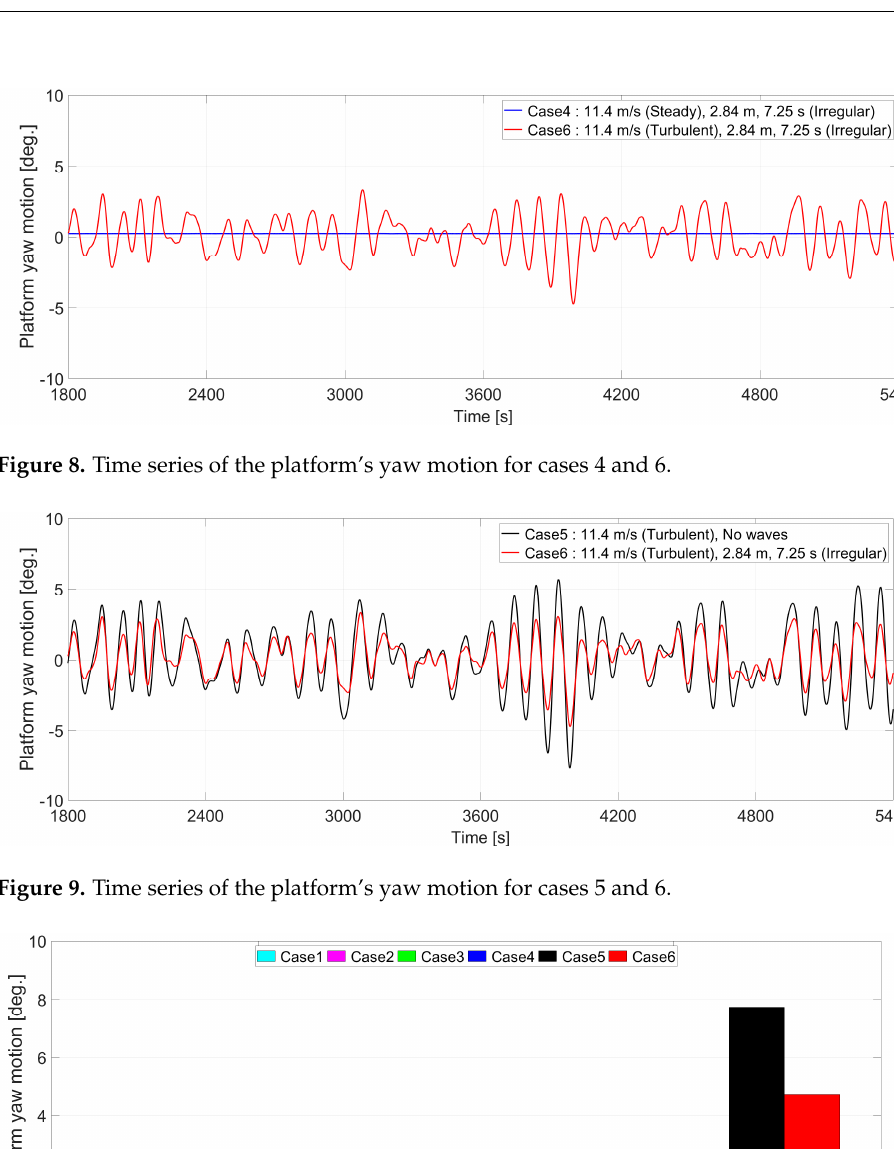
Figure 8. Time series of the platform’s yaw motion for cases 4 and 6.